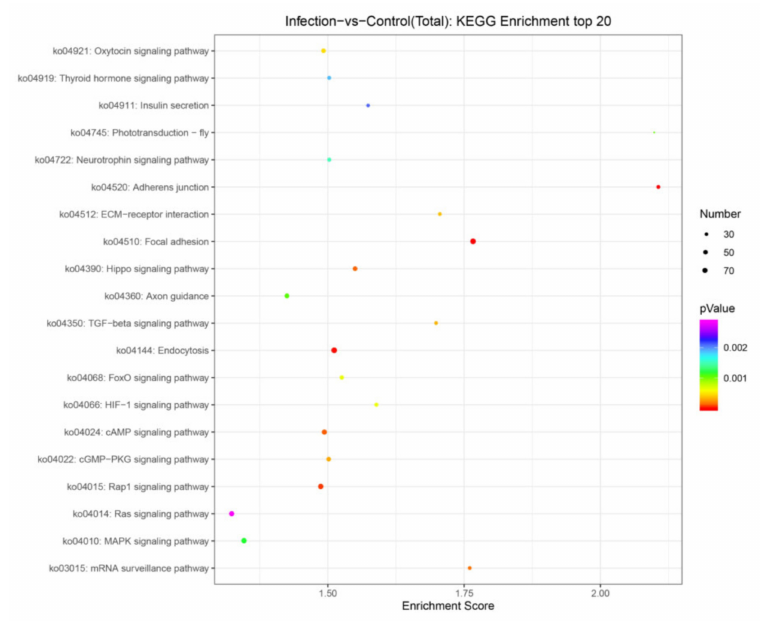
Figure 6. Top 20 KEGG pathways of the target genes of the differentially expressed miRNAs.